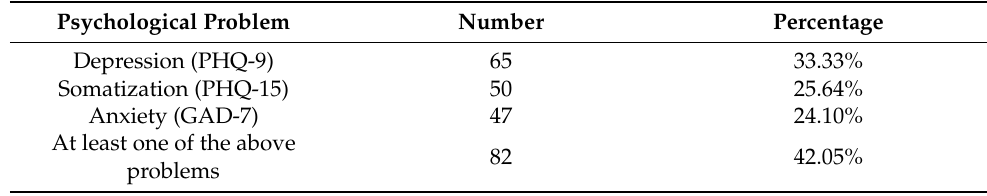
Table 3. Numbers of participants having psychological problems and percentage in all 195 participants.